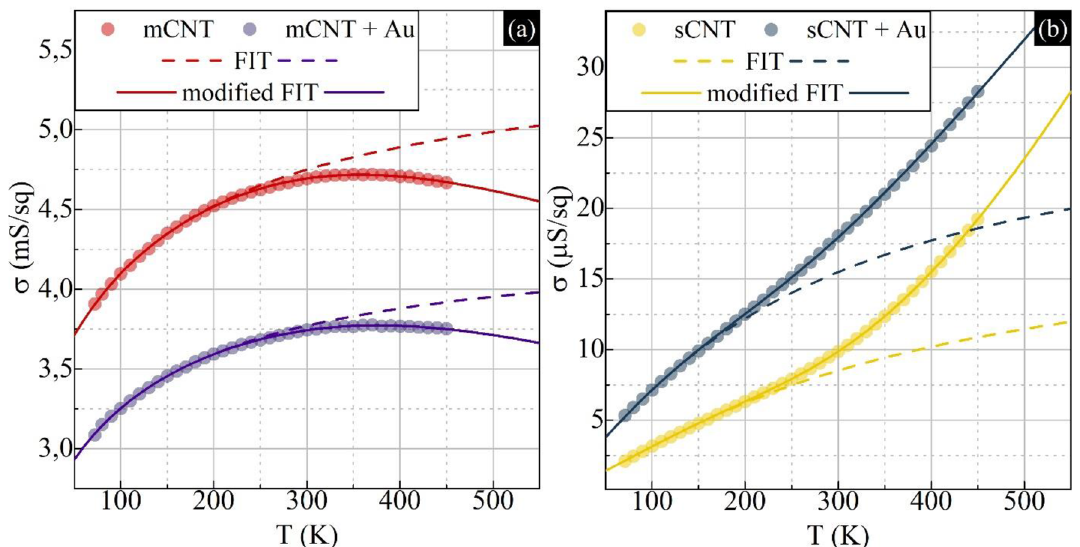
Figure 3. The conductivity dependence from temperature for electronic transport evaluation. ( a ) mCNT and mCNT + Au comparison with fitted Fluctuation Induced Tunneling model with (solid line) and without (dashed line) high-temperature components. ( b ) sCNT and sCNT + Au comparison with the fitted FIT model with (solid line) and without (dashed line) high-temperature components. All collected data has been characterized by uncertainty less than 1% (see “Supplementary